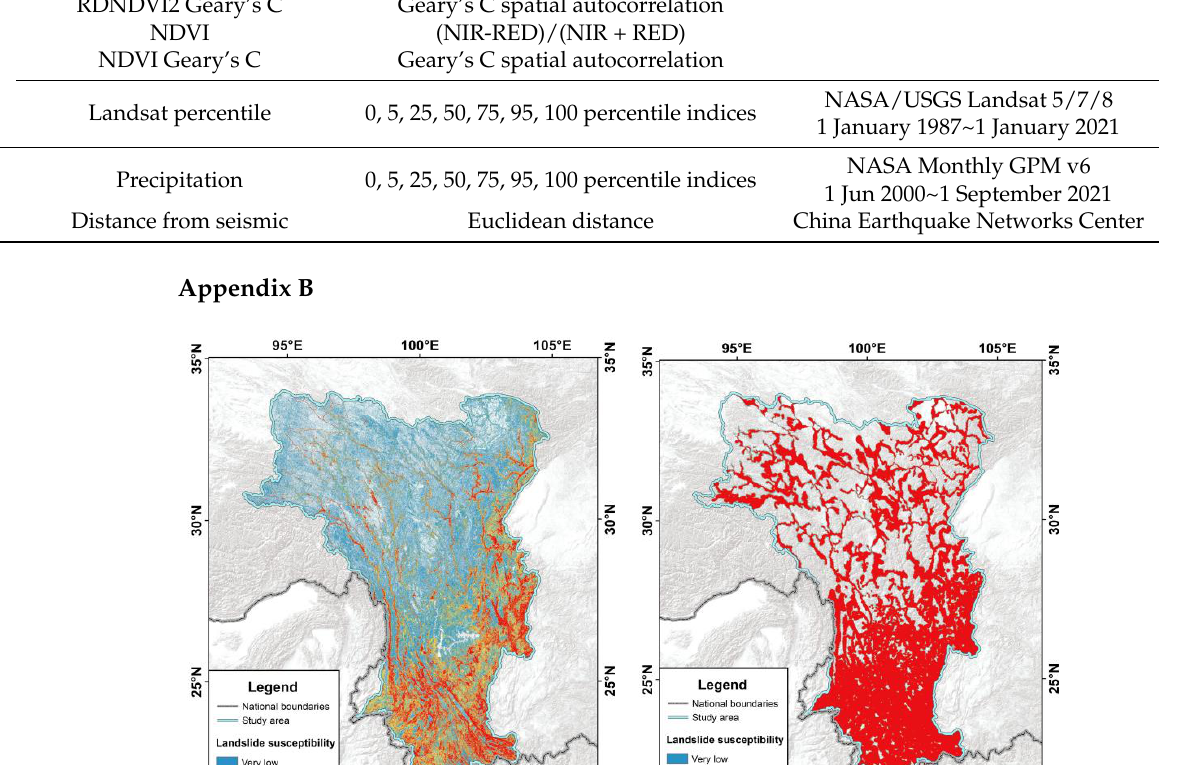
Figure A2. Point density map of training landslide data.